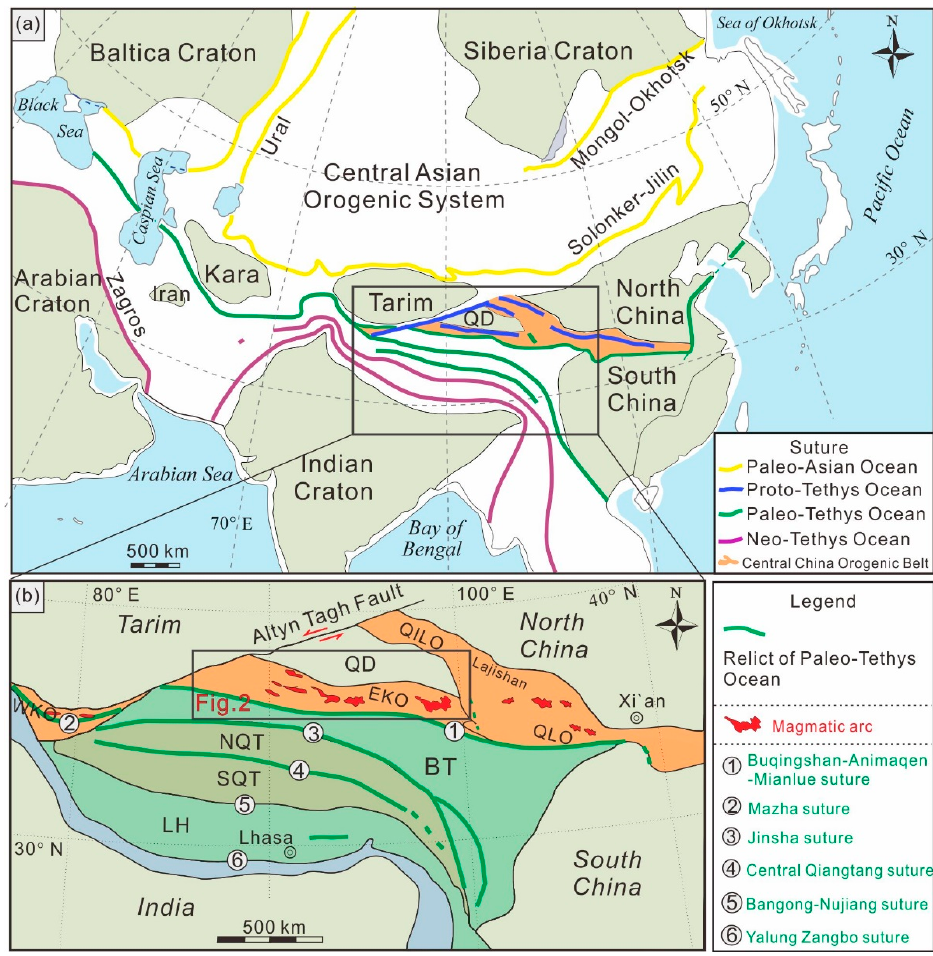
Figure 1. ( a ) Simplified tectonic map of Asia showing cratons and sutures (modified from Zuza and Yin [52]), and ( b ) tectonic framework of the Northern Tibetan Plateau (modified from Roger et al. and Xu et al. [11,51]). Kara—Karakum; NQT—North Qiangtang terrane; SQT—South Qiangtang